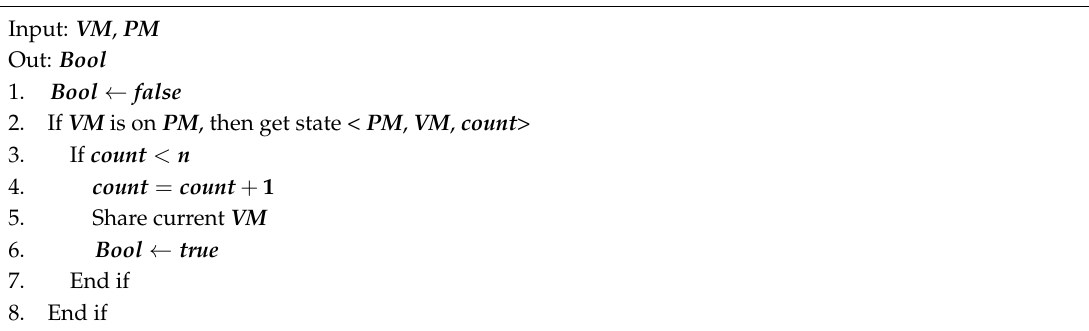
Algorithm 2 VM sharing algorithm (VMSA)